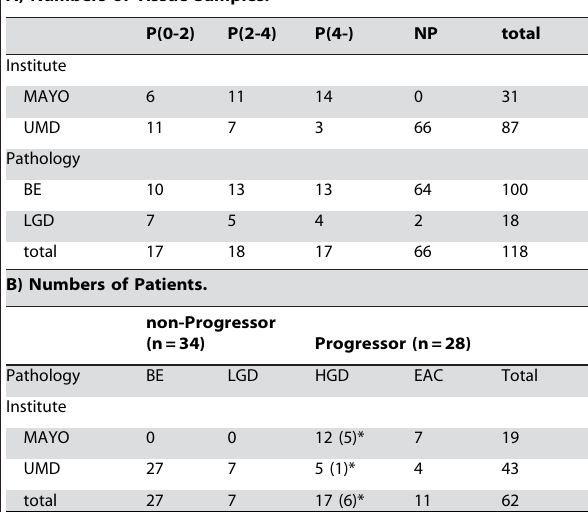
Table 1. Numbers of Tissue Samples and Patients, Classifications, and